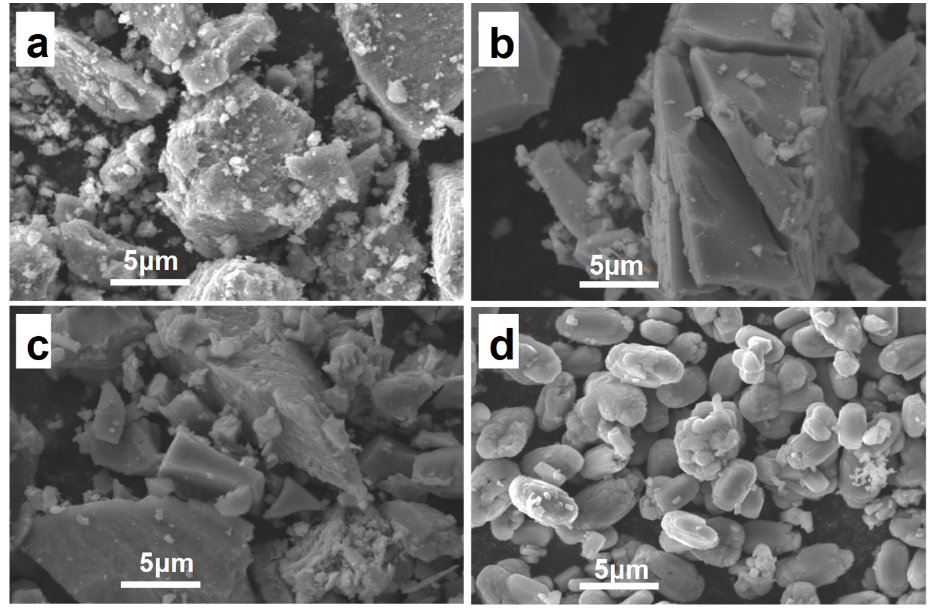
Figure 1. SEM images of the precursors: ( a ) R0, ( b ) R5, ( c ) R15 and ( d )